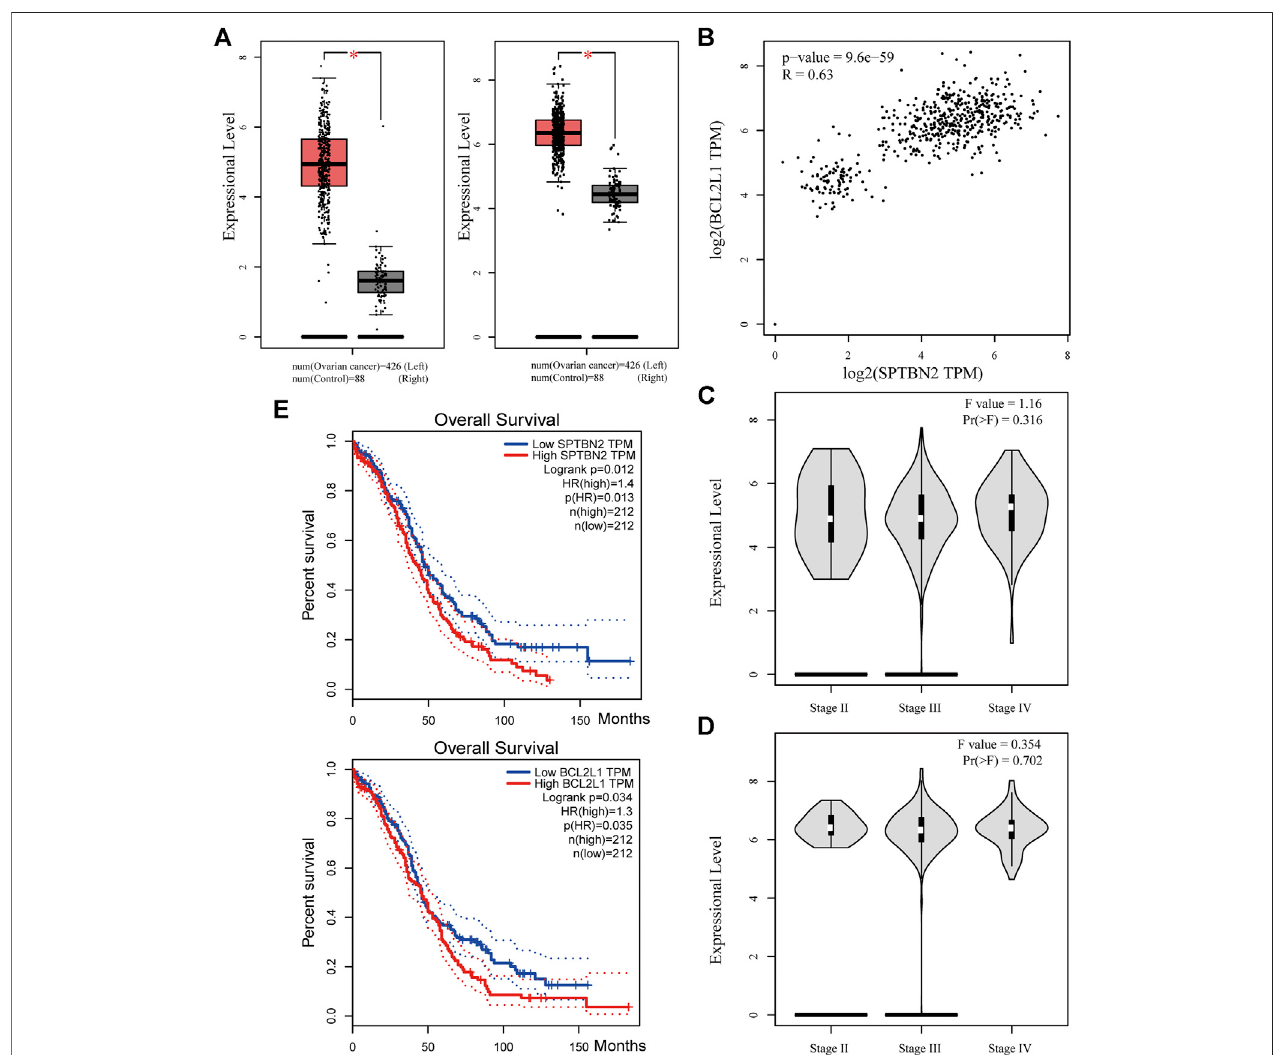
FIGURE 8 | Clinical value of the two hub genes. (A) Expressional levels between OV and NC groups for SPTBN2 (left) and BCL2L1 (right) ( n (cid:2) 426 for OV or 88 for NC, p < 0.05). (B) The correlation analysis for SPTBN2 and BCL2L1 ( p (cid:2) 9.6E-59, R (cid:2) 0.63). (C) The overall survival for patients with high or low SPTBN2 (upper panel, log-rank p (cid:2) 0.012, HR (cid:2) 1.4) and with high or low BCL2L1 (upper panel, log-rank p (cid:2) 0.034, HR (cid:2) 1.3). (D) Expression of SPTBN2 with different stages in OV (F (cid:2) 1.16, Pr( > F) (cid:2) 0.316). (E) Expression of SPTBN2 with different stages in OV (F (cid:2) 0.354, Pr( > F) (cid:2) 0.702).